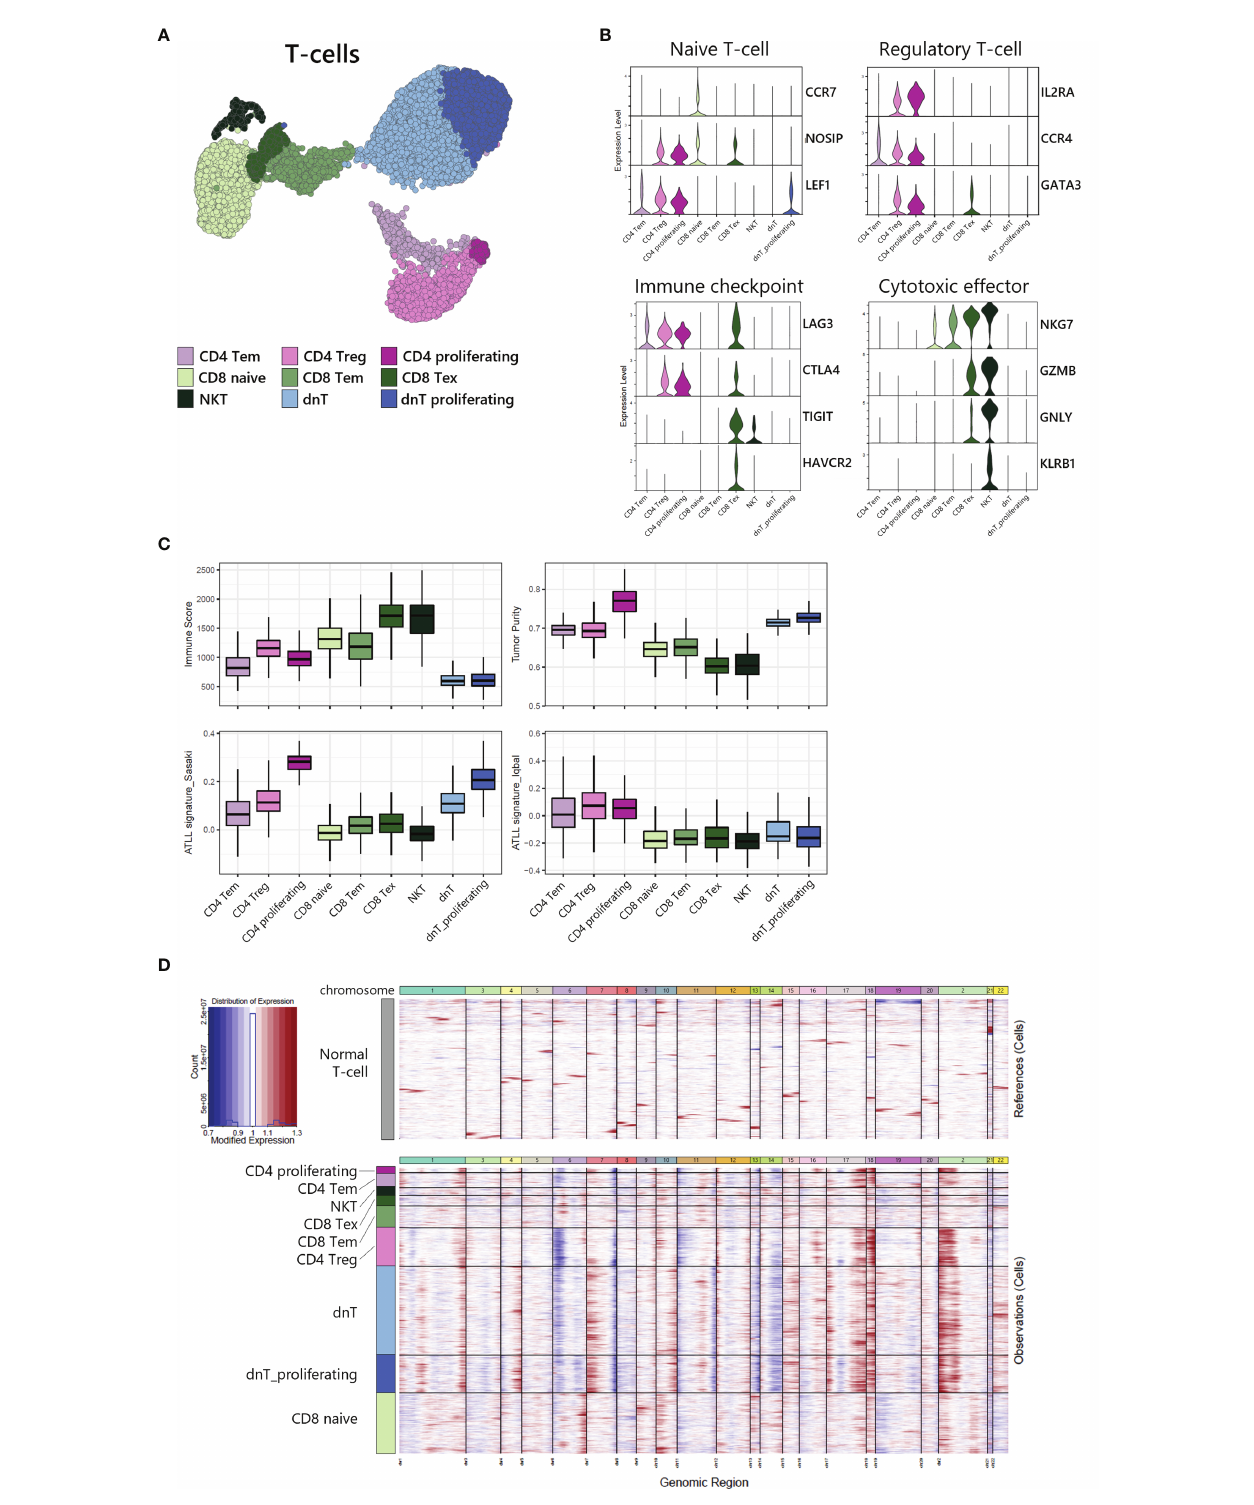
FIGURE 3 | Tumor identi fi cation within T-cell subpopulation. (A) UMAP of the 9,625 cell T-cell population reveals 9 distinct clusters. (B) Functional gene expression of T-cell subtypes. (C) Estimated Immune Score and Tumor Purity of T-cell subtypes. (D) Heatmap of inferred copy number changes (infercnv) compared to T-cells from healthy